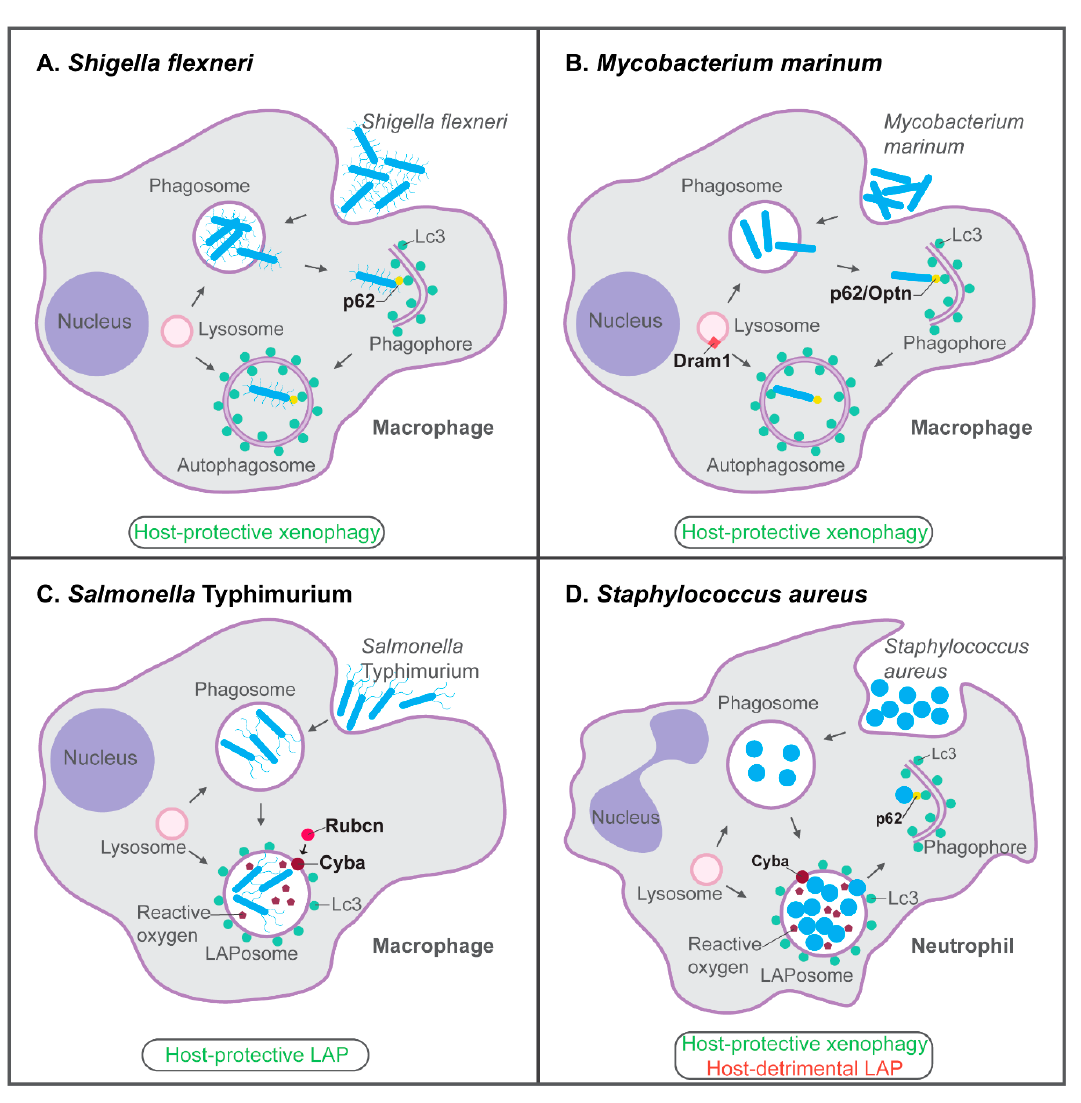
Figure 3. Host-protective and host-detrimental interactions of bacterial pathogens with the autophagy machinery in zebrafish infection models. ( A ) p62-dependent xenophagy restricts growth of S. flexneri bacteria in macrophages of the zebrafish host. ( B ) In the zebrafish M. marinum model, p62, Optn, and Dram1 are required for host resistance. p62 and Optn both mediate xenophagy in infected macrophages, while Dram1, an integral membrane protein of intracellular vesicles including lysosomes, promotes vesicle fusion events. ( C ) LAP, which requires the signaling molecule Rubicon (Rubcn) and the Cyba component of NADPH oxidase, is the predominant defense response of zebrafish macrophages to S. Typhimurium infection. ( D ) In zebrafish neutrophils, Cyba-mediated LAP provides a replication niche for S. aureus , while p62-mediated xenophagy counteracts the growth of bacteria that may be released from phagosomes or LAPosomes. Functions of the proteins indicated in bold have been demonstrated by knockdown, mutation, and / or overexpression analyses. See the text for references.